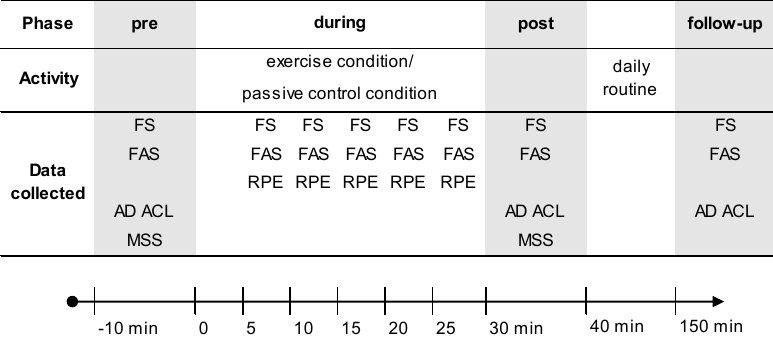
Figure 1. Study procedure including data collection points for each condition. Heart rate was measured throughout the condition. FS: Feeling Scale; FAS: Felt Arousal Scale; RPE: Ratings of Perceived Exertion; AD ACL: Activation Deactivation Adjective Check List; MSS: Mood Survey Scale.